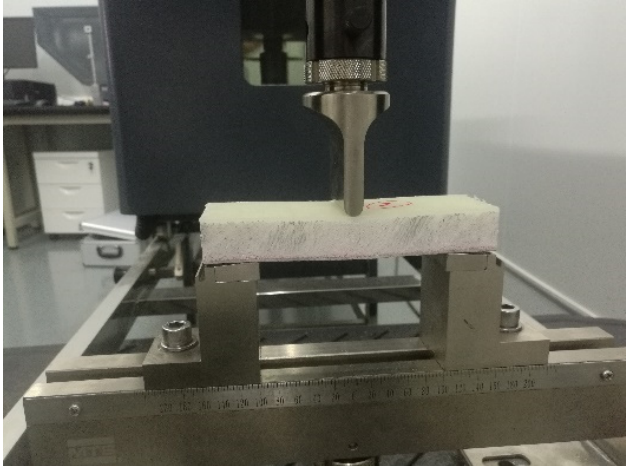
Figure 1. Three-point bending test with sample.